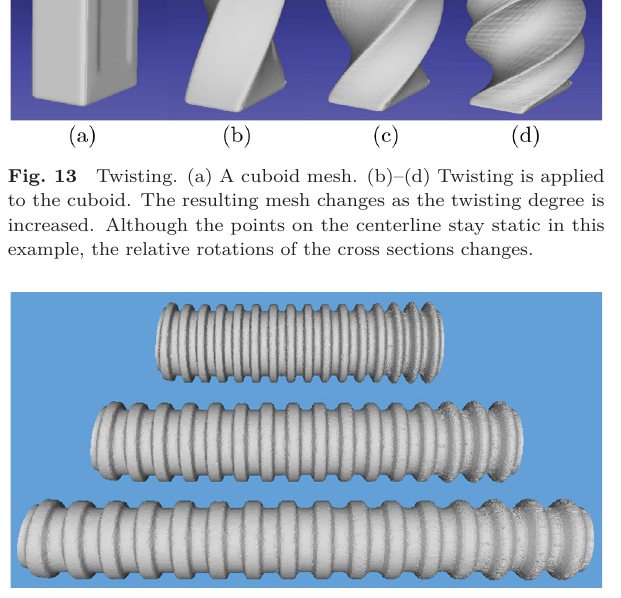
Fig. 14 A flexible tube stretched to different lengths. This is done by changing the point spacing on the target parametric